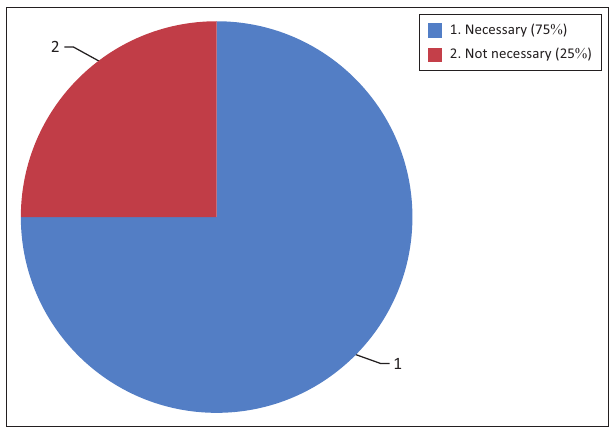
FIG URE 10: Need for a central capital management